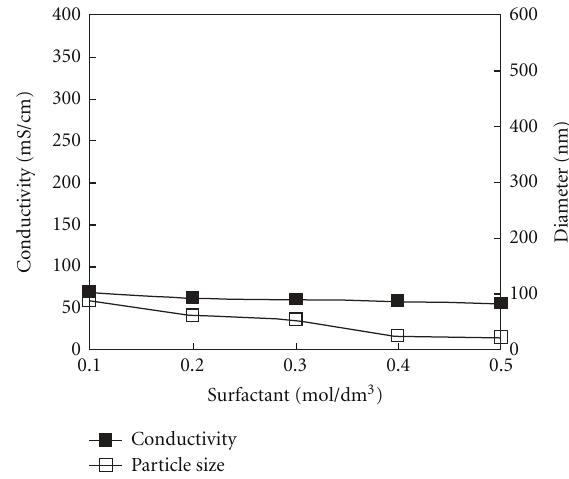
Figure 1: Conductivity and particle diameter as a function of con- centration of Cu(NO 3 )2 · 3H 2 O.